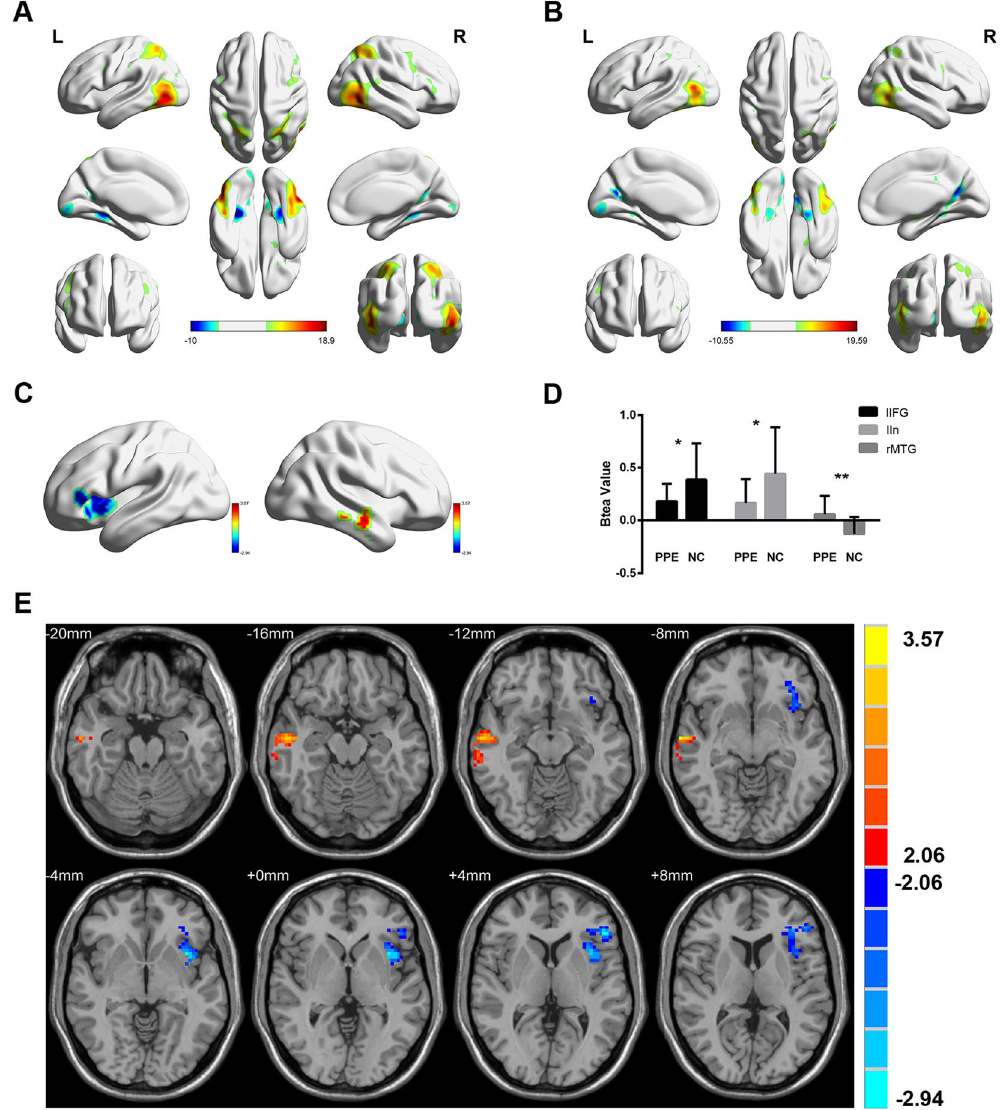
Figure 1. Brain responses to erotic pictures. The mean task fMRI activation maps of ( A ) PE patients and ( B ) NC subjects. ( C,E ) Independent sample t-test results indicating the voxels in which the PE patients demonstrated significantly altered activation compared to the NC group (T maps threshold at p < 0.05, AlphaSim corrected). ( D ) The beta values for the left inferior frontal gyrus, left insula and right middle temporal gyrus. rMTG: right middle temporal gyrus; lIFG: left inferior frontal gyrus; lIn: left